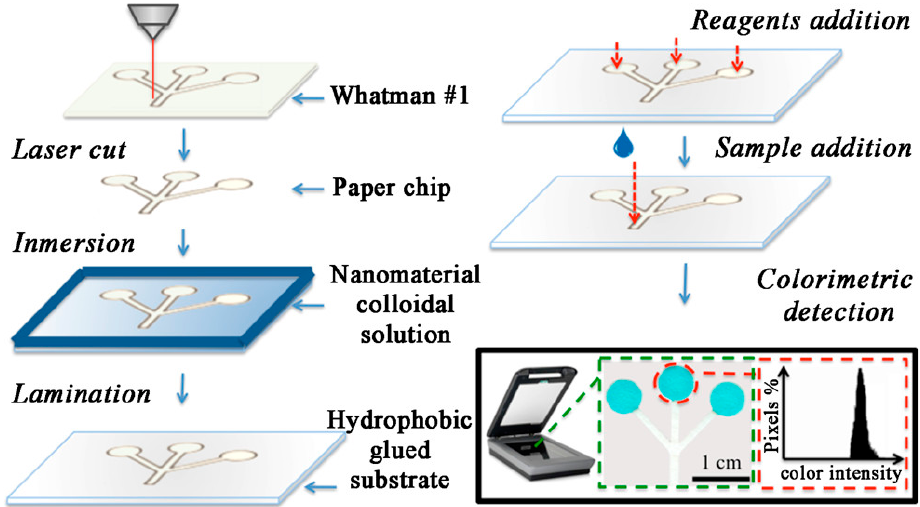
Figure 8. Schematic illustration of disposable microfluidic paper-based devices (µPADs). Image reproduced with permission from [183] . Copyright 2015 American Chemical Society.